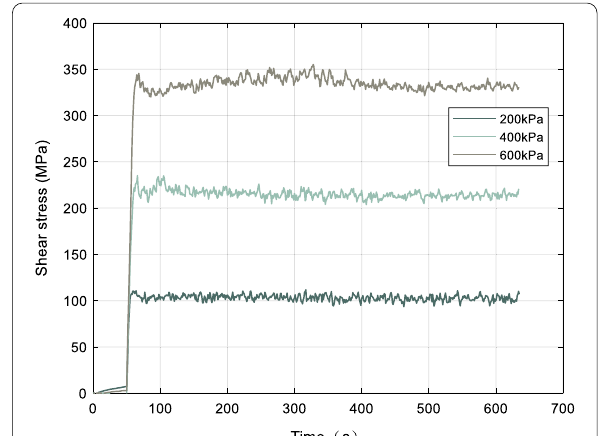
Fig. 11 Relationship between time and the shear stress under different normal stresses